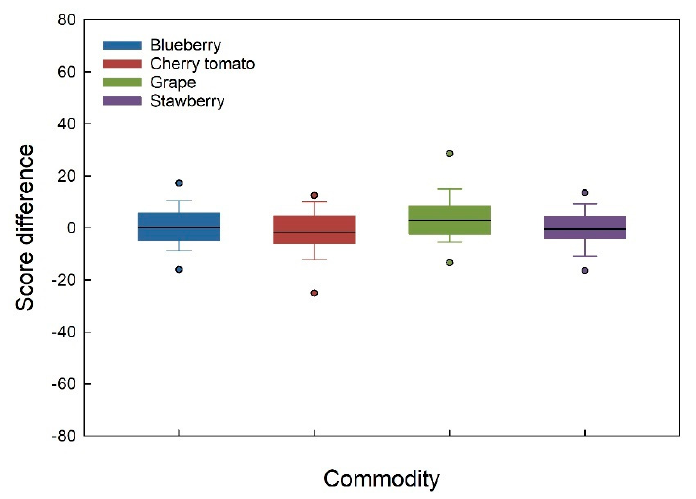
Figure 3. Boxplots representing appearance (IA-A) for each commodity. The dots represent outliers. The results obtained with the evaluations of appearance suggest that imaging tech- nology is a promising approach for nudging consumers towards online purchasing of fruits and vegetables. Not only was there no significant difference when comparing the means of combined commodities, but also, each commodity separately did not show significant